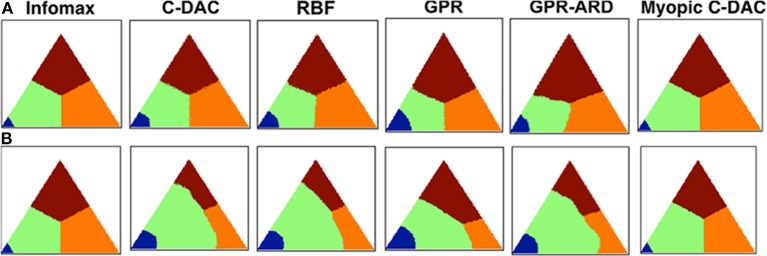
Decision policies as a function of switching cost. (A) No switch-cost environment: (c, cs, β) = (0.1, 0, 0.9). (B) Switch-cost environment: (c, cs, β) = (0.1, 0.1, 0.9). Triangle represents the belief state space, (p1, p2), under affine transform for visual symmetry. Color-coding denotes the action prescribed by each policy for different values of the belief state vector. Blue: stop and declare location 1 as target. Green: fixate location 1. Orange: fixate location 2. Brown: fixate location 3. All policies are deterministic (see Methods).